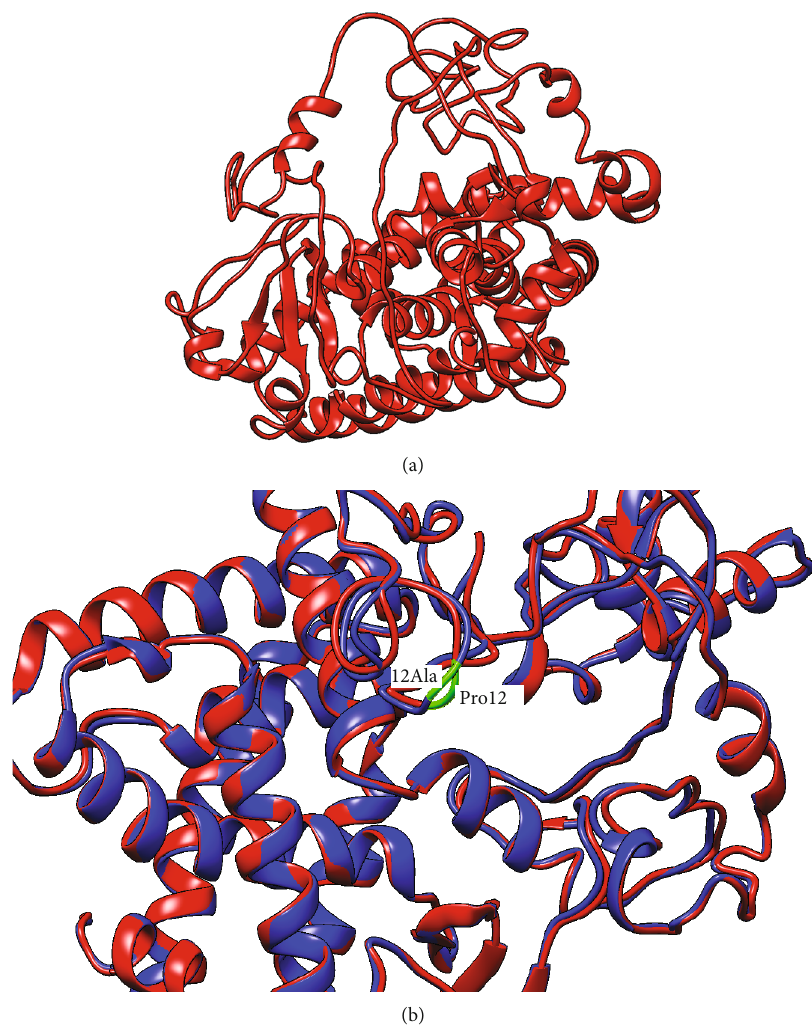
Figure 6: Superimposition of secondary structures of mutant and wild-type by UCSF Chimera: (a) whole PPAR γ 2 protein; (b) mutation site, Pro12 allele (red), and 12Ala allele (blue). Mutation site was highlighted in